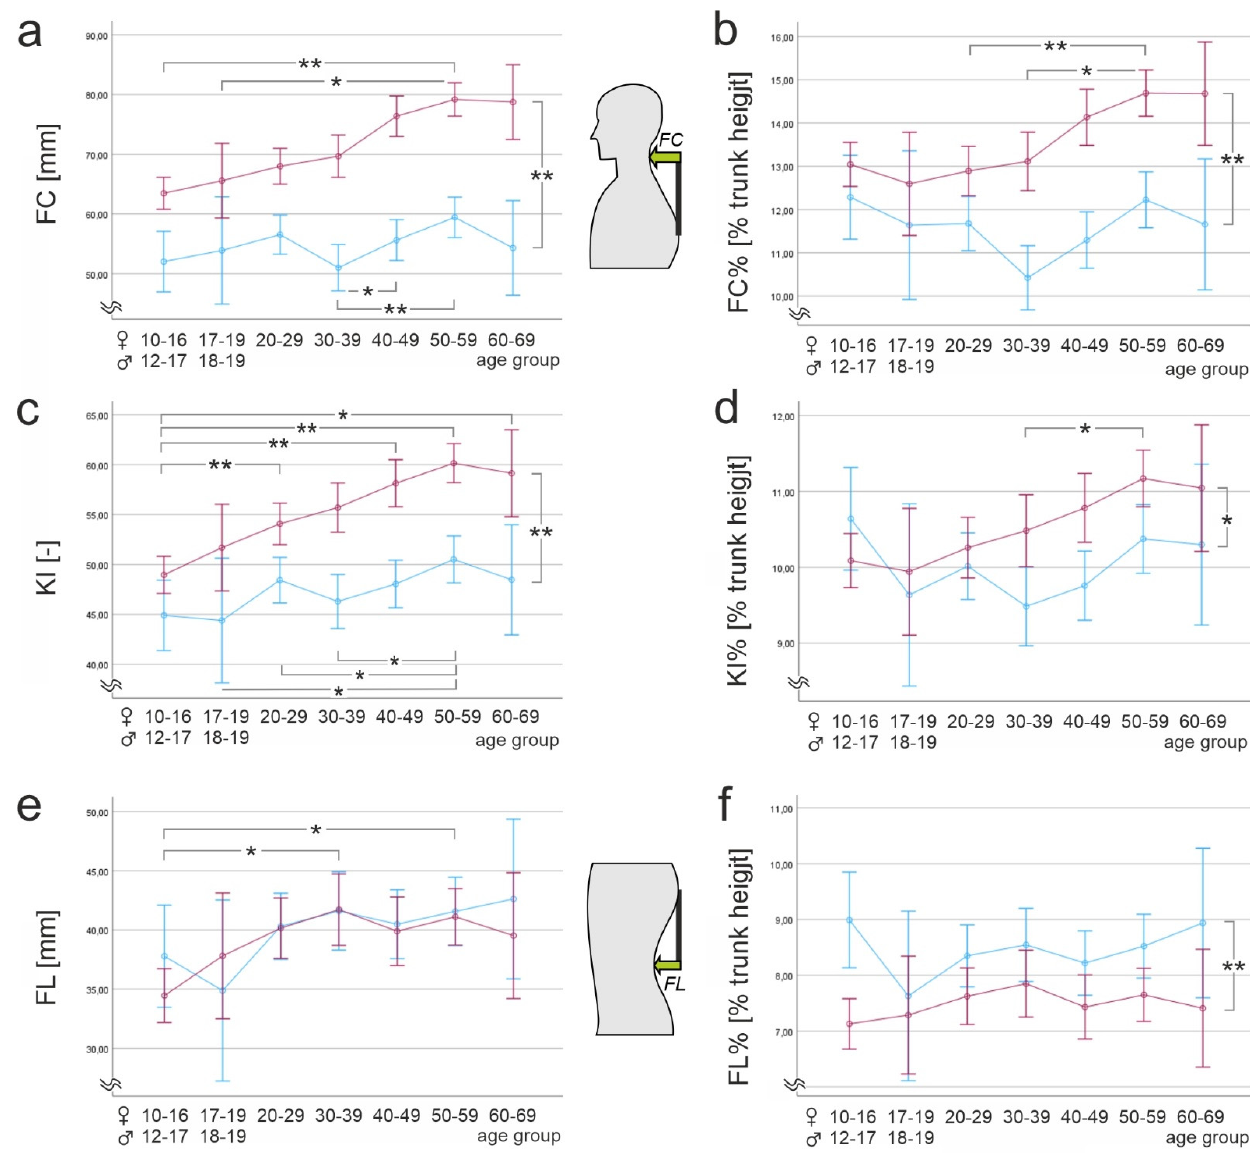
Figure 2. Posture parameters depending on age and sex. ( a ) flèche cervicale (FC); ( b ) flèche cervicale normalized to trunk height (FC%); ( c ) kyphosis index (KI); ( d ) kyphosis index normalized to trunk height (KI%); ( e ) flèche lombaire (FL); ( f ) flèche lombaire normalized to trunk height (FL%). Blue: women; red: men. Note that Y-scales do not start at 0 for better resolution. * p < 0.05, ** p < 0.001. Table 2. Reference data of non-normalized posture parameters. Non-normally distributed data according to the Kolmogorov–Smirnov test are shown in italics. FC, flèche cervicale ; FL, flèche lombaire ; KI, kyphosis index.